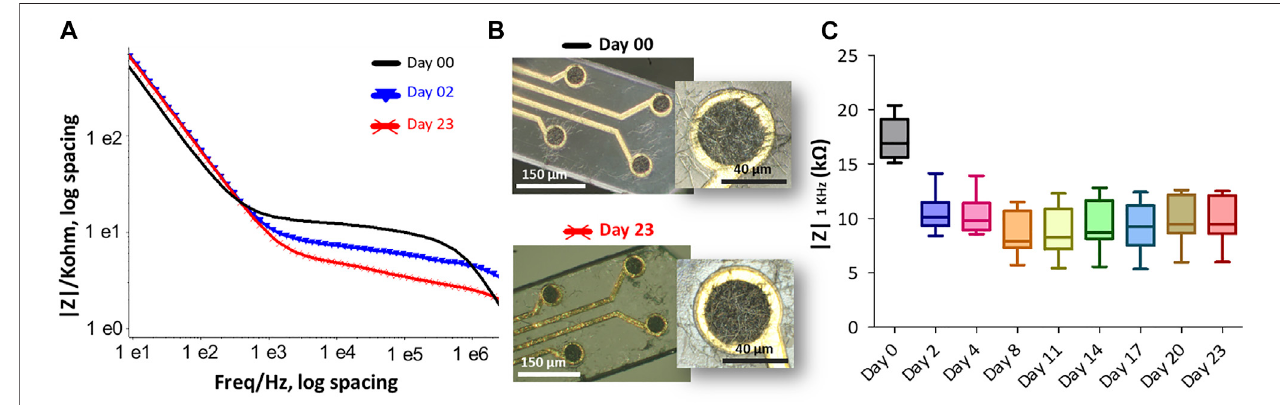
FIGURE 7 | The effect of accelerated thermal aging on the PEDOT-CNF composite was examined in PBS buffer at 57 ° C for 23 days. (A) Impedance magnitude of PEDOT-CNF composite at Day 0 (black), Day 2 (blue) and Day 23 (red). Platinum wire was used as counter and reference electrodes. (B) Hirox microscope images of fl exible probe (black) before immersion and (red) after 23 days of soaking in PBS at 57 ° C. (C) The evolution of electrode impedance at 1 KHz represented in a standard box-and-whisker plot where the sample number n (cid:2) 8.